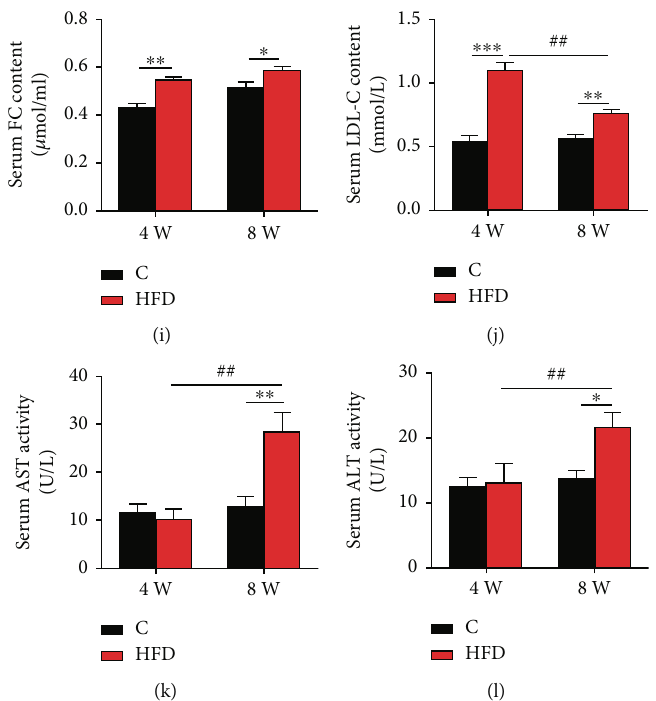
Figure 1: E ff ects of HFD on growth performance, organ indices, serum lipid pro fi les, and liver health in Nile tilapia after 4-week and 8-week feeding trials. (a) Body weight ( n = 3 tanks, 30 fi sh/tank); (b) survival rate (SR, n = 3 tanks); (c) condition factor (CF, n = 12 ); (d) mesenteric fat index (MFI, n = 12 ); (e) hepatosomatic index (HSI, n = 12 ); (f, g) triglyceride (TG) and free fatty acid (FFA) in serum ( n = 9 ); (h, i) total cholesterol (TC) and free cholesterol (FC) in serum ( n = 9 ); (j) low-density lipoprotein cholesterol (LDL-C) in serum ( n = 9 ); (k, l) serum symbols indicate the di ff erences between 4-week and 8-week feeding trials of the same lipid level diet, # P < 0 : 05 , ## P < 0 : 01 , ### P < 0 : 001 ; C: control diet; HFD: high-fat diet. SR ð % Þ = final number of fish × 100/initialnumber of fish . CF ð % Þ = body weight × 100/body length 3 . MFI ð % Þ = 100 × mesentericfat weight/individual fishbody weight . HSI ð % Þ = 100 × liver weight/individual fishbody weight